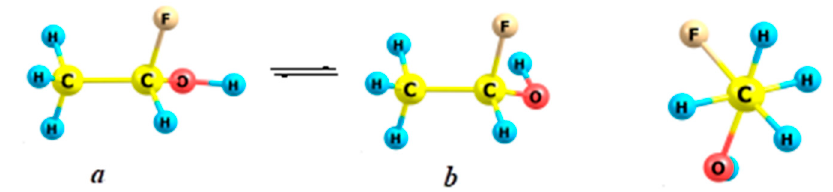
Figure 17. Conformers of S-1-fluoroethanol. Adapted with modification [257].